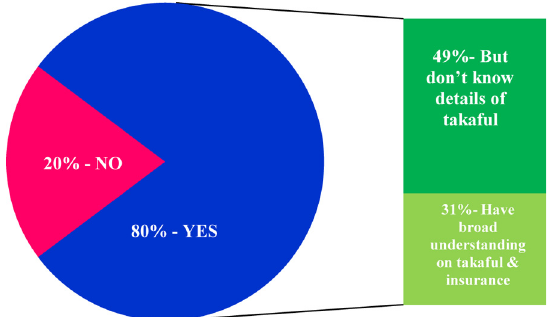
Figure 5. Composition of respondents ’ awareness on the availability of tak (cid:1)